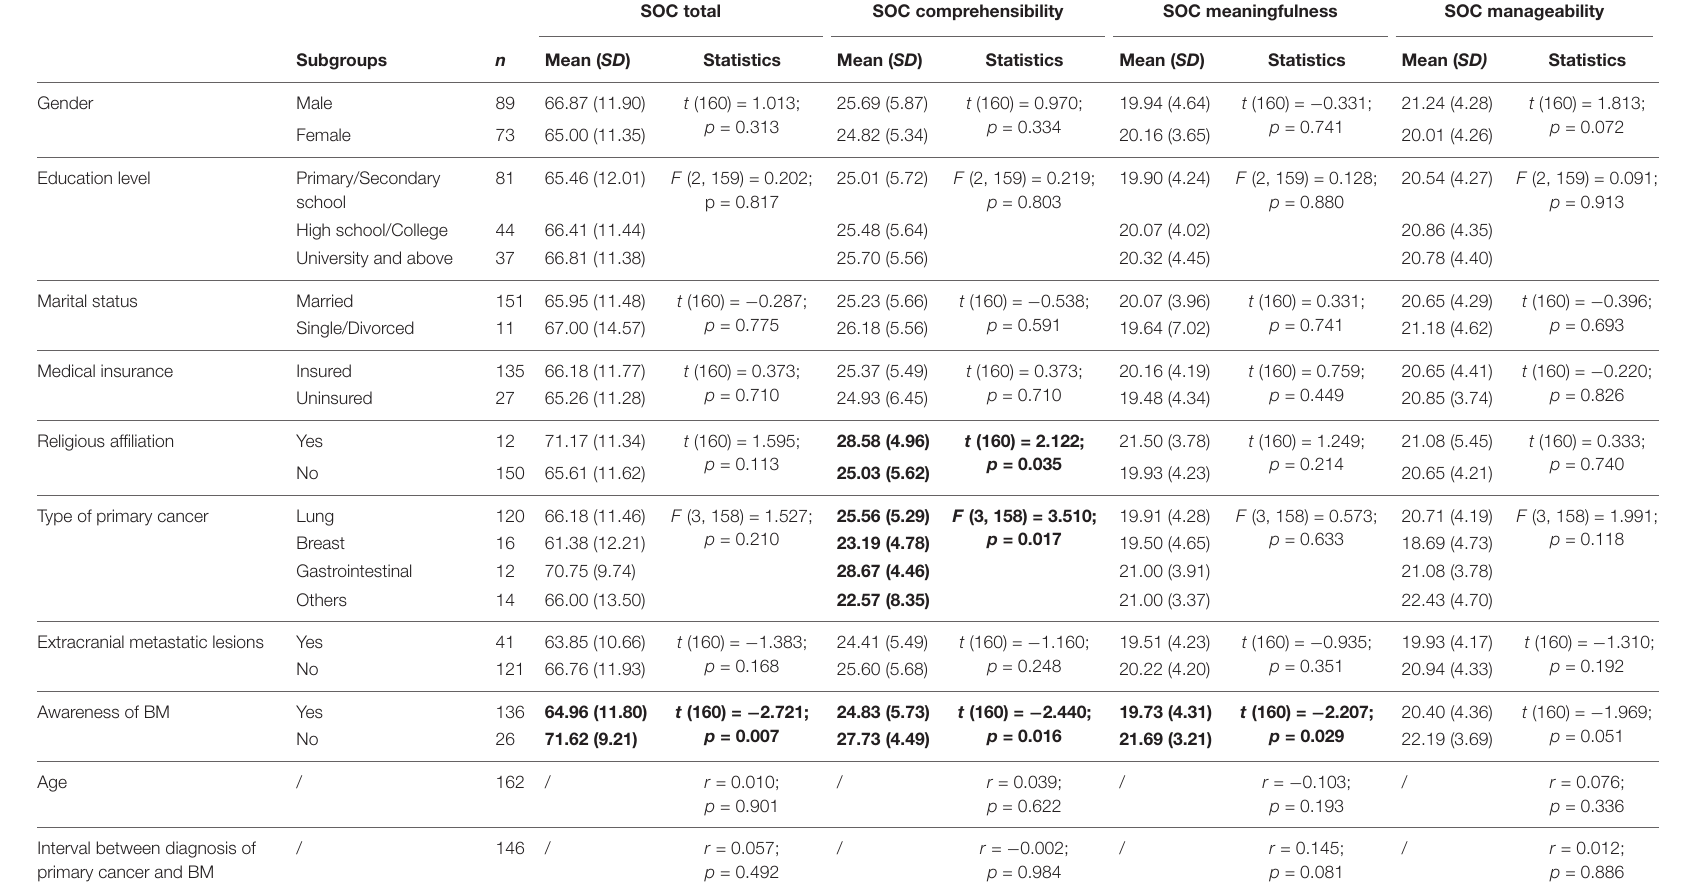
TABLE 5 | Association between sociodemographic and clinical characteristics and SOC in patients with